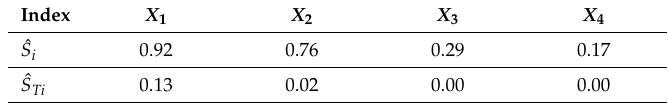
Table 5. First order and total effect sensitivity indices for the Young’s modulus using Bayesian